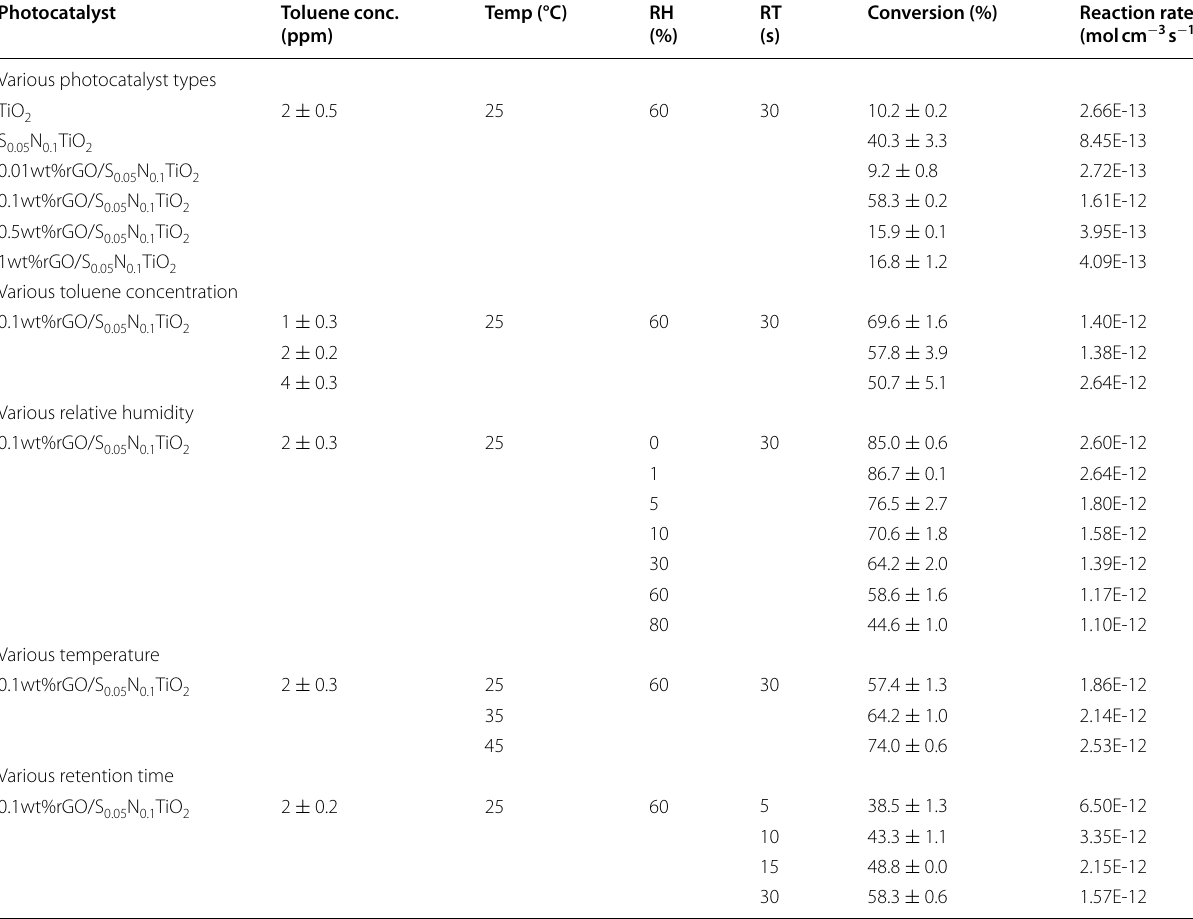
Table 3 Conversion and the retention time during photocatalytic degradation study under various applied conditions Photocatalyst